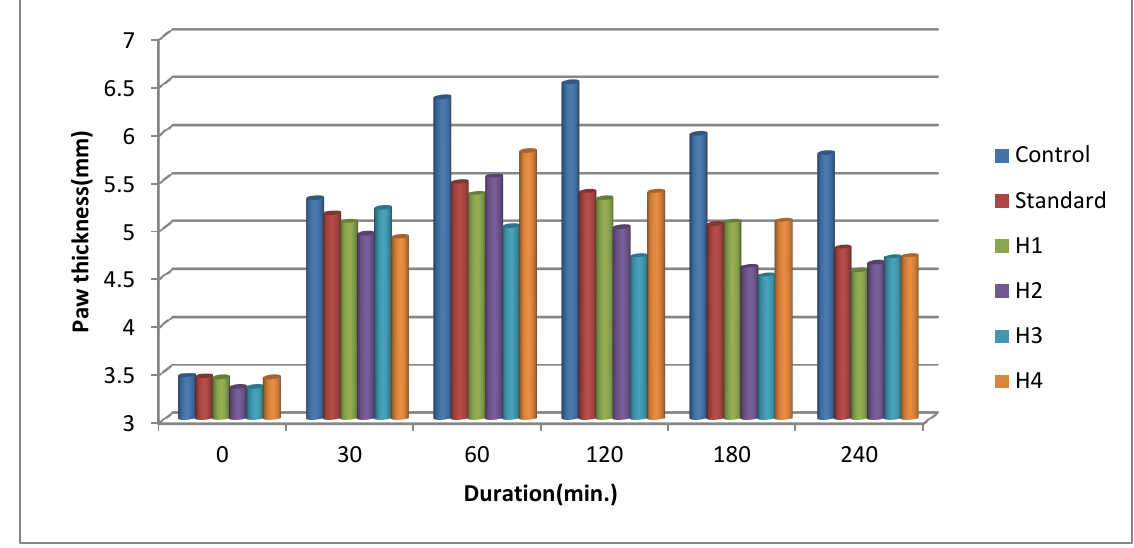
Figure 2. Effect of dimethyl sulfoxide, Fenoprofen and compounds (H1-H4) on egg-white induced paw edema in rats. Results are expressed as mean ± SEM (n = 6 for each